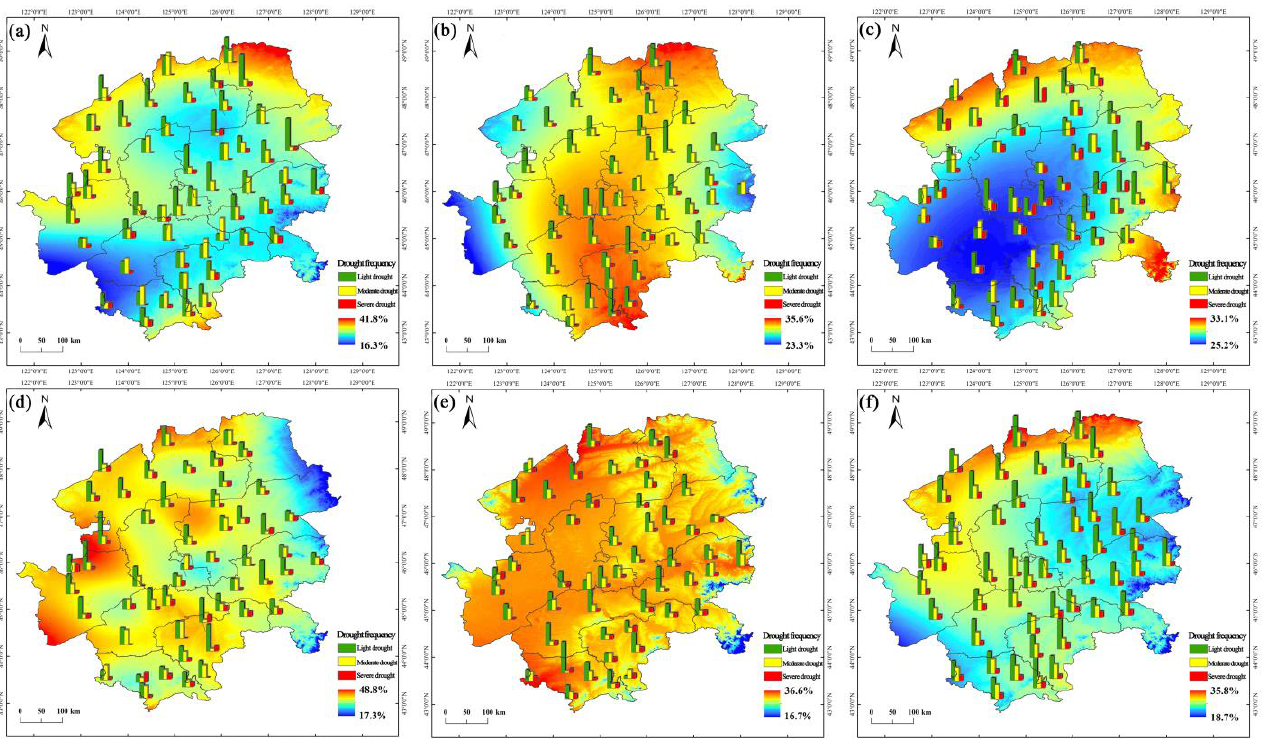
Figure 7. Spatial distribution of drought frequency in different growth stages of spring maize: ( a ) the sowing to seedling stage; ( b ) the seedling to jointing stage; ( c ) the jointing to heading stage; ( d ) the heading to milk mature stage; ( e ) the milk mature to mature stage; and ( f ) the whole growth stage.